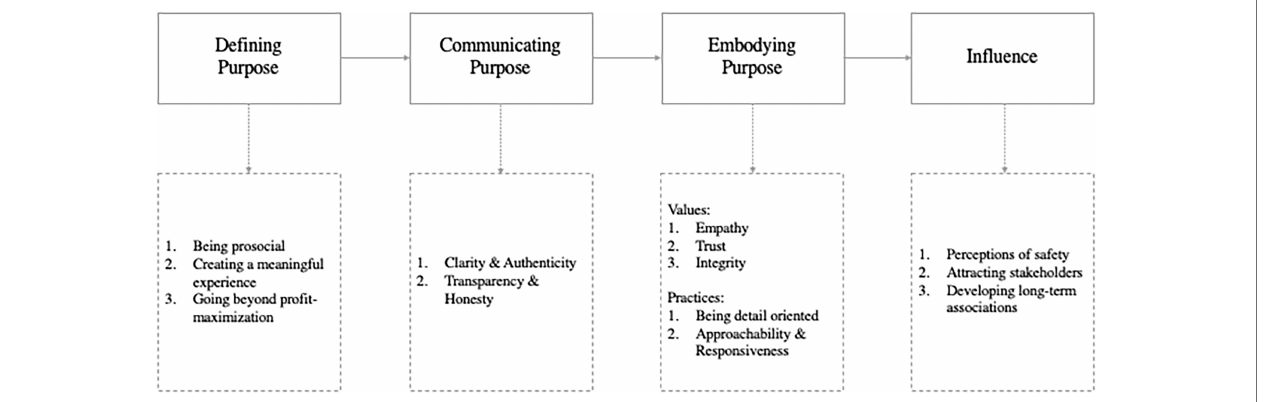
FIGURE 1 | Implementing purpose in tourism organizations.